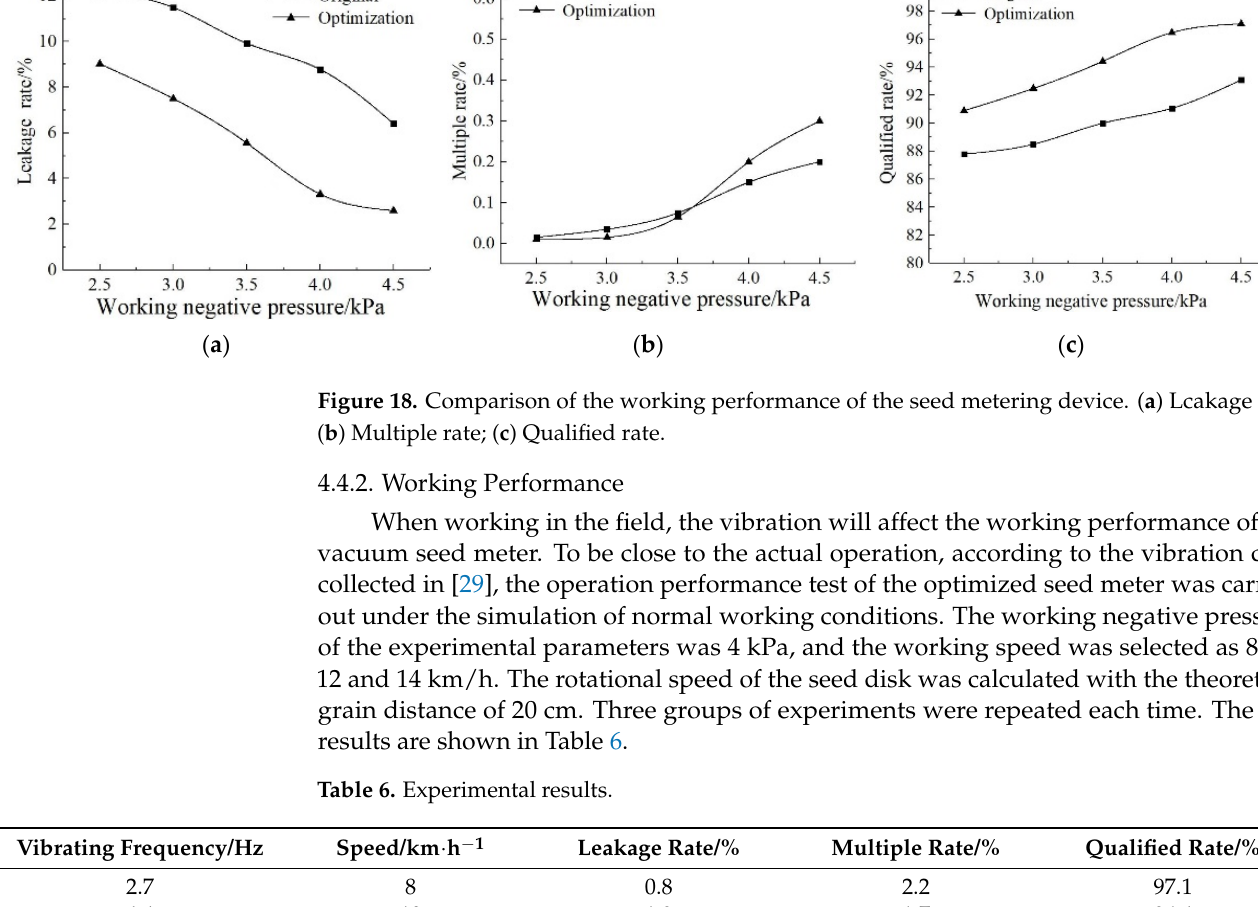
Figure 17. Influence of two-factor interaction on the seed picking-up time.